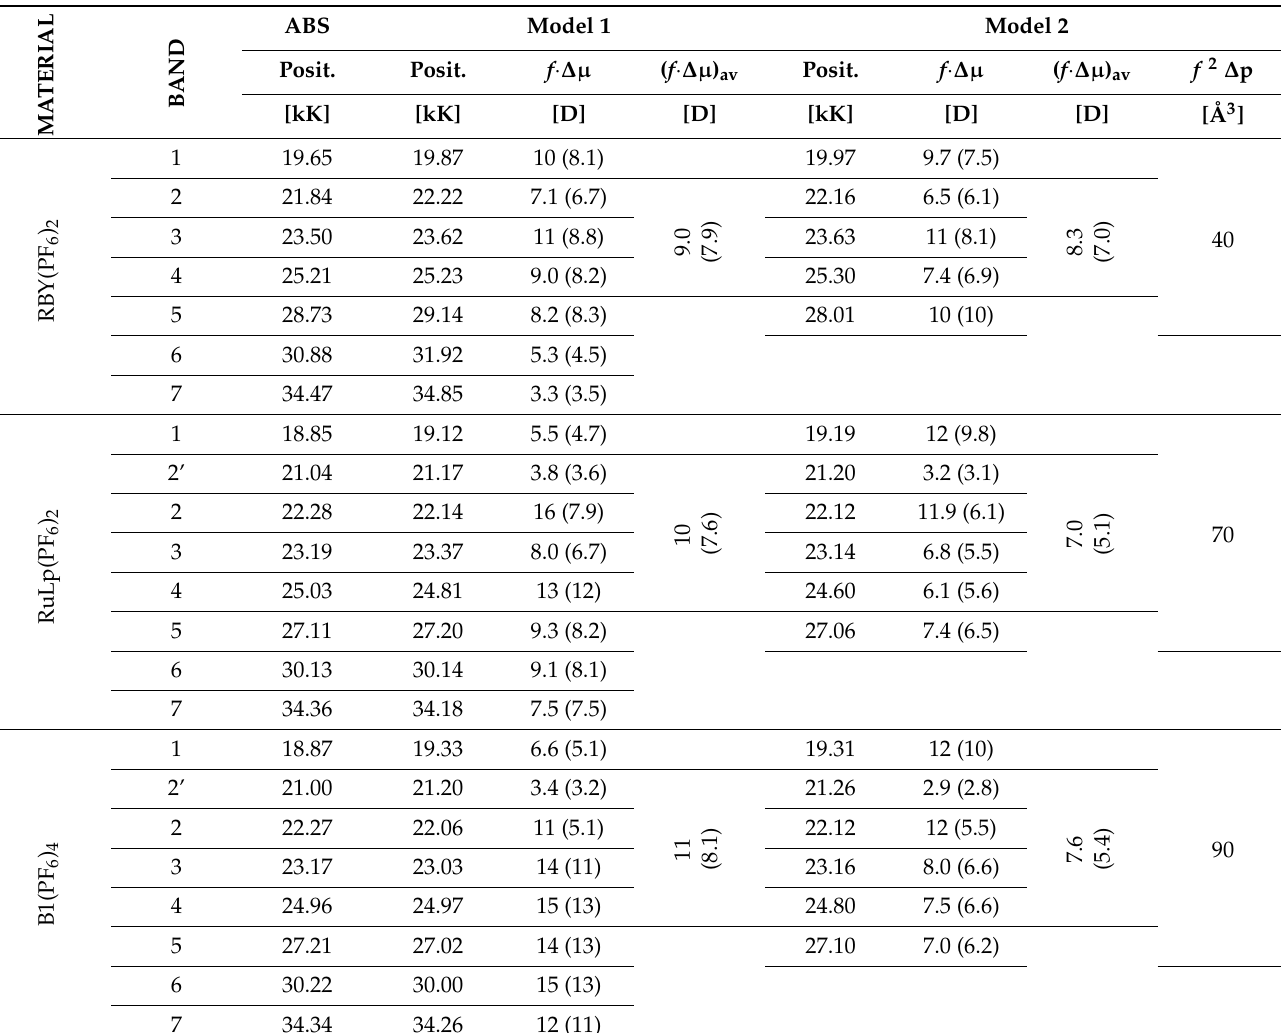
Table 4. Results of fitting model parameters for EA spectra of Ru(II) complexes. The uncertainty of parameters ∆ µ and ∆ p is around